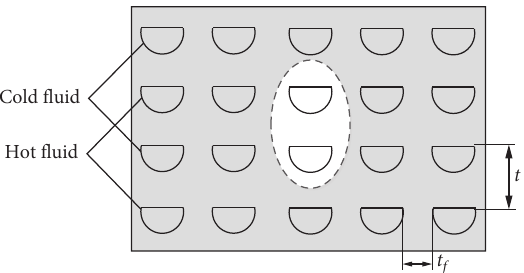
Figure 5: Cross section of the printed circuit heat